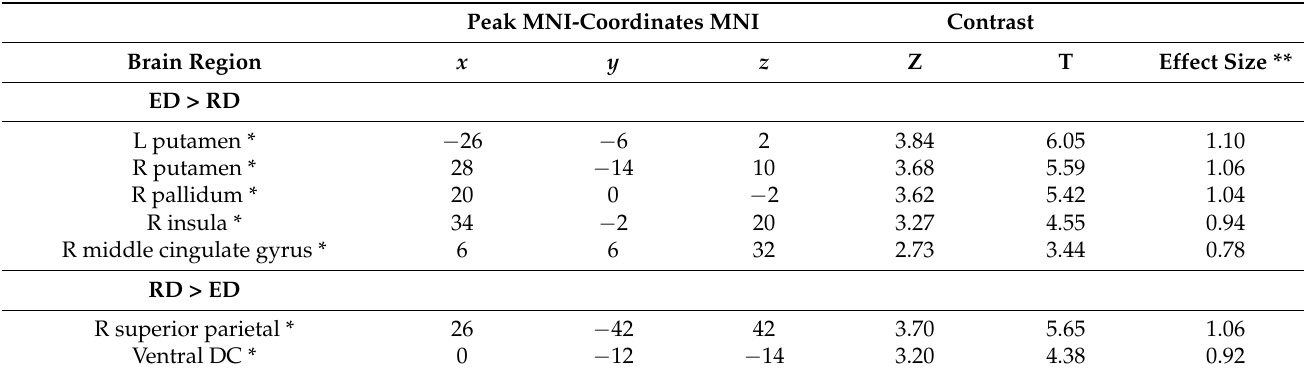
Table 2. Brain regions with stronger activation in response to emotional (PD × ED + UD × ED) vs. rational (PD × RD + UD × RD)